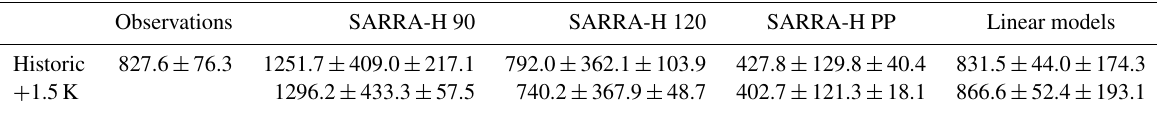
Table 4. Simulated millet yields (kgha − 1 ) in West Africa for observations and four crop models for the historic time period and at 1.5K. The first uncertainty value is the inter-annual variability and the second is the spread across the RCM–GCM ensemble.